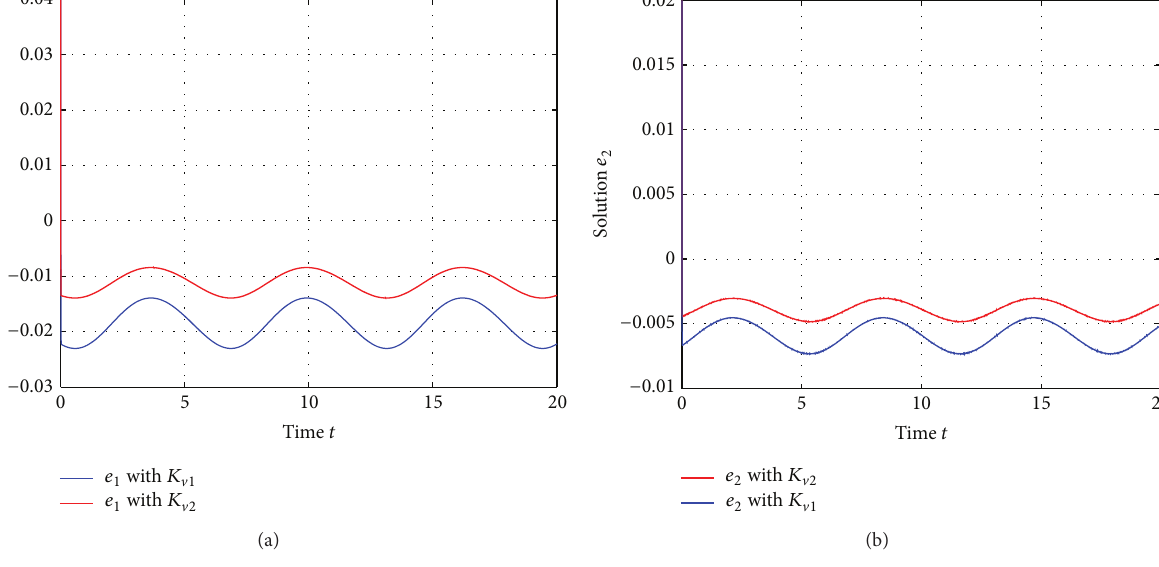
Figure 6: The trajectory of error system 𝑒(𝑡) : (a) 𝑒 1 (𝑡) with 𝐾 V 1 and 𝐾 V 2 , (b) 𝑒 2 (𝑡) with 𝐾 V 1 and 𝐾 V 2 ; where 𝐾 V 1 = ( 300 5 10 360 ) and 𝐾 V 2 = ( 500 5 10 560 )